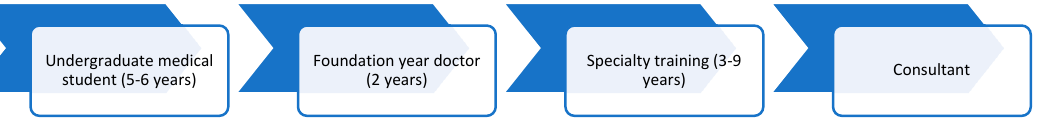
Figure 1. Training pathway in England [12].